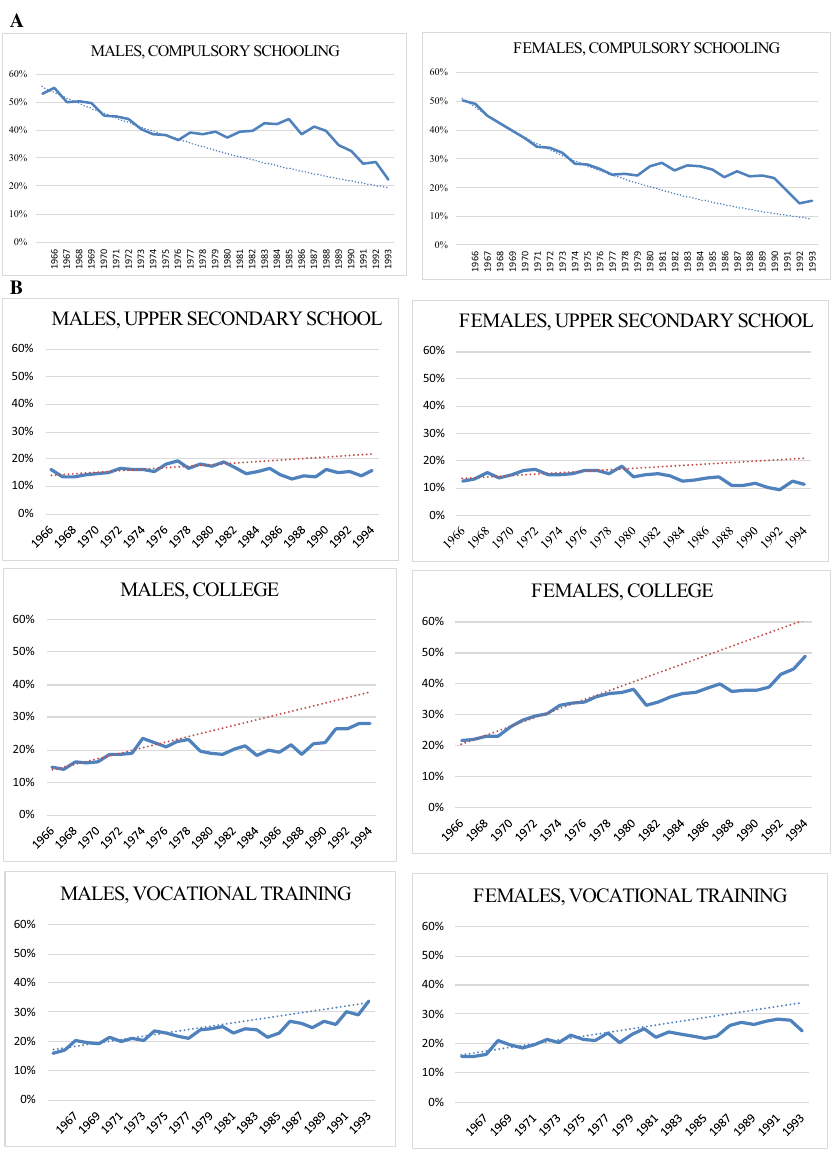
Fig.1 Educational attainment at age 25 by year of birth, % of Spanish natives with compulsory education. a The straight line represents the percentage of people of different birth cohorts that did not achieve high school between 1966 and 1993. The dotted line shows a lineal trend of that percentage extrapolating from 1966 and 1976. In the regressions, we use the cohorts born between 1969 and 1984. b The straight line represents the percentage of people of different birth cohorts that achieved high school, college and a vocational degree between 1966 and 1993. The dotted line shows a lineal trend of those percentages extrapolating from 1966 and 1976. In the regressions, we use the cohorts born between 1969 and 1984. Source : EPA (Spanish Employment Survey), years